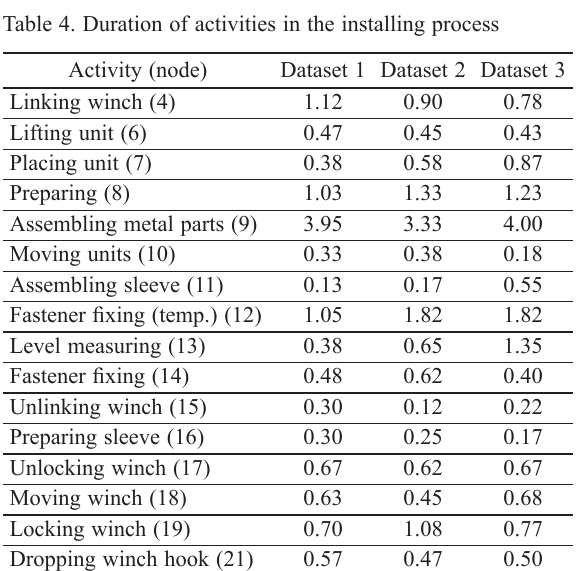
Table 4. Duration of activities in the installing process